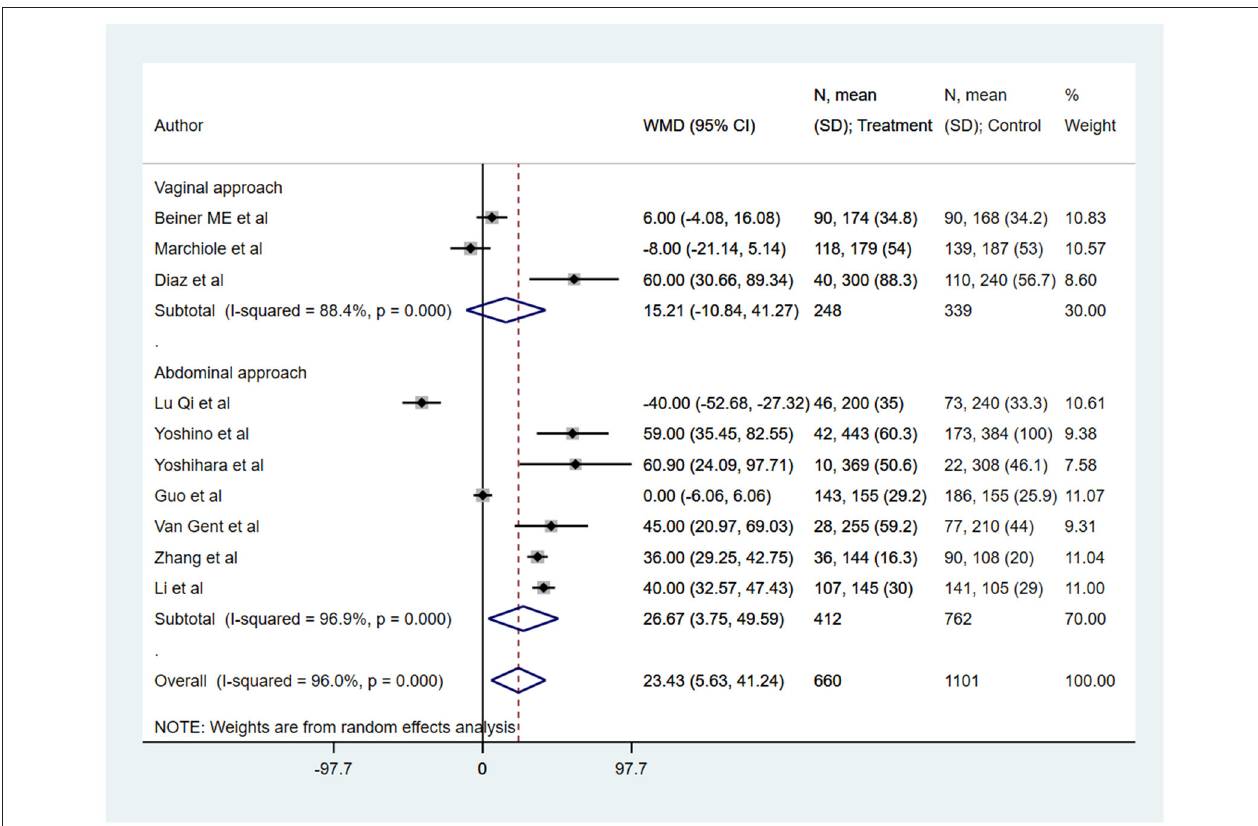
FIGURE 2 | The pooled effect size for the operative time (in min) is based on comparison between radical trachelectomy and hysterectomy in patients with early-stage cervical cancer.